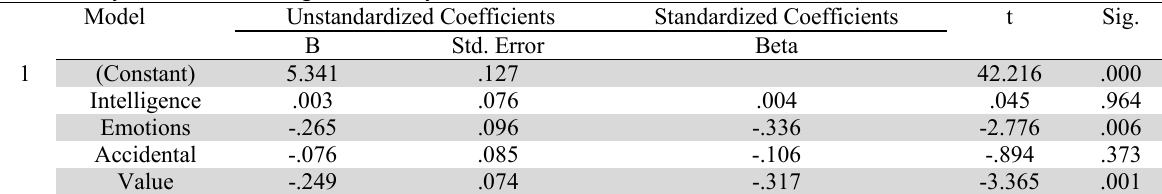
The summary of the results of regression analysis Model